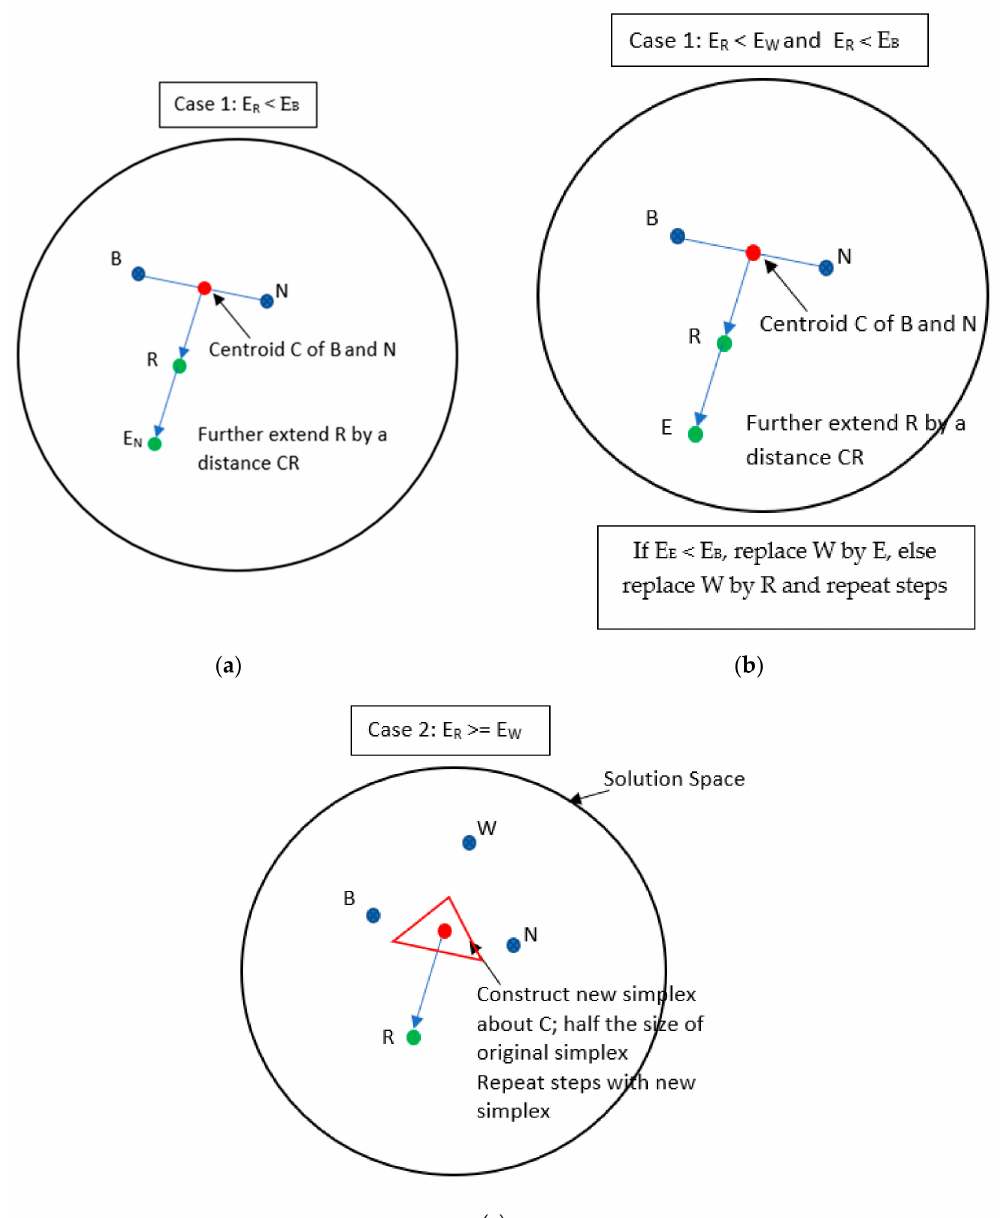
Figure 11. Schematic representation of the Nelder-Mead simplex search in a 2-dimensional space. Di ff erent cases are represented in three di ff erent sub-figures ( a , b ) and ( c ). ( a ) To begin reflect the worst vertex (W) through the centroid of the other vertices. Following steps as demonstrated in Figure 11b or Figure 11c depend of the outcomes of point R. ( b ) If the error at R is lower than B, extend R in the same direction to point E; else repeat previous steps with new simplex B-N-R. ( c ) If the error at R is more than W, calculate error at C; if error at C is less than B, construct a fat simplex about half the size about the centroid. Repeat the process till the final solution is